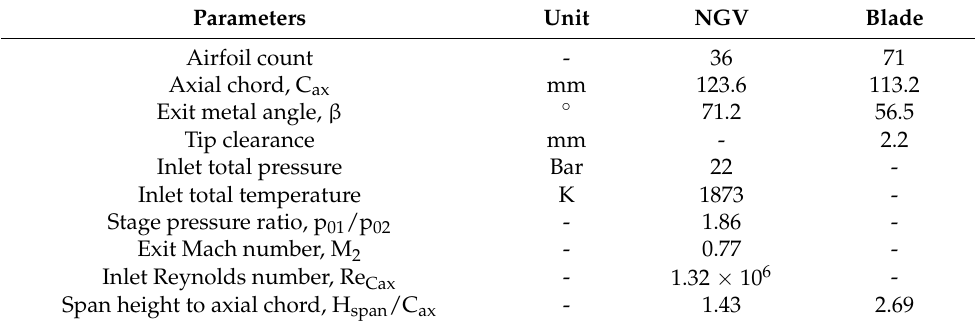
Figure 2. Computational domain and surface mesh distribution. Table 1. NGV geometric parameters and boundary conditions at 50% span height.